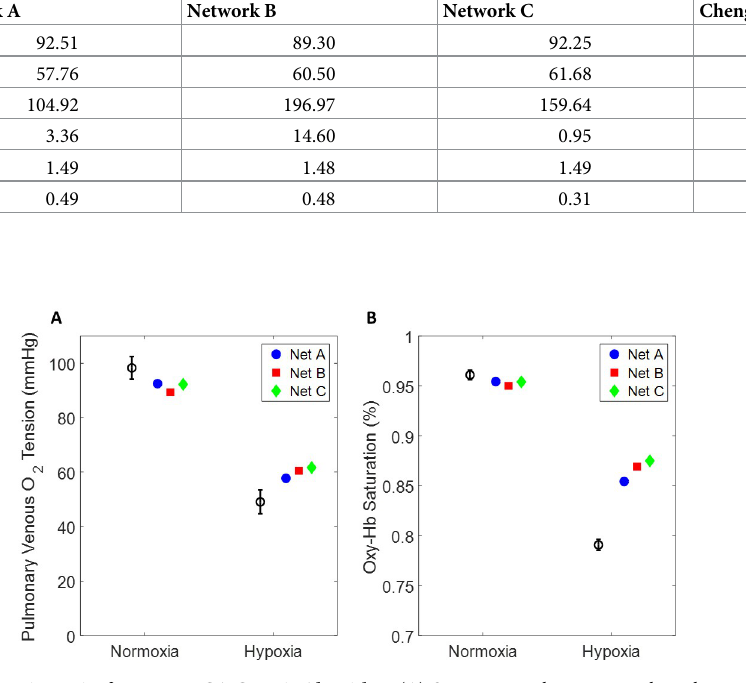
Fig 5. Fits from BELUGA Genetic Algorithm. (A) Oxygen partial pressure in the pulmonary vein. The block circle and error bars denote data from Cheng et al., the blue circle denotes network A, the red square denotes network B, and the green diamond denotes network C. The plotted point is the best fit individual from BELUGA (parameters reported in Table 2). (B) The same data and results from (A) but expressed in terms of oxyhemoglobin saturation.